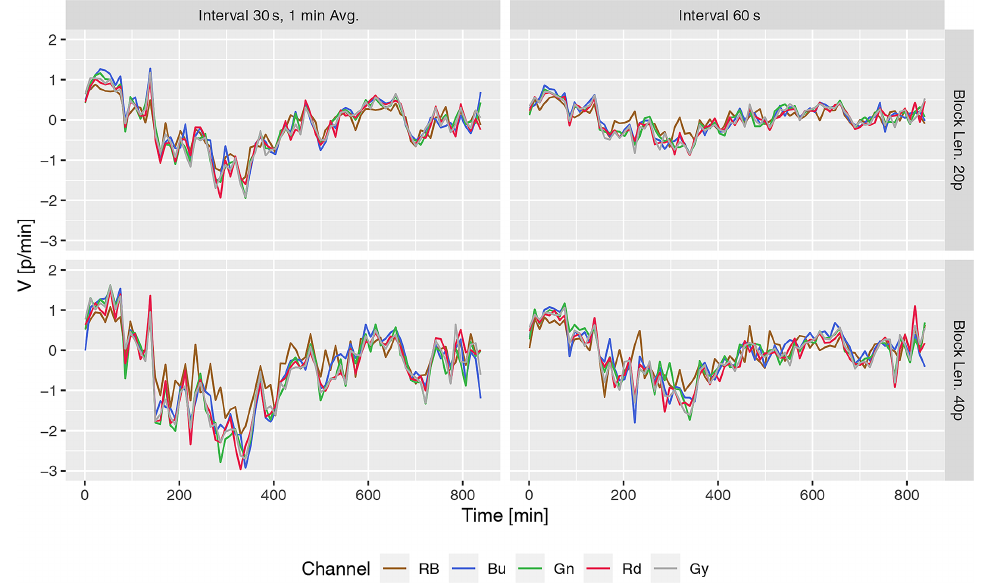
Figure 6. Same as Fig. 5, but for the V component of the